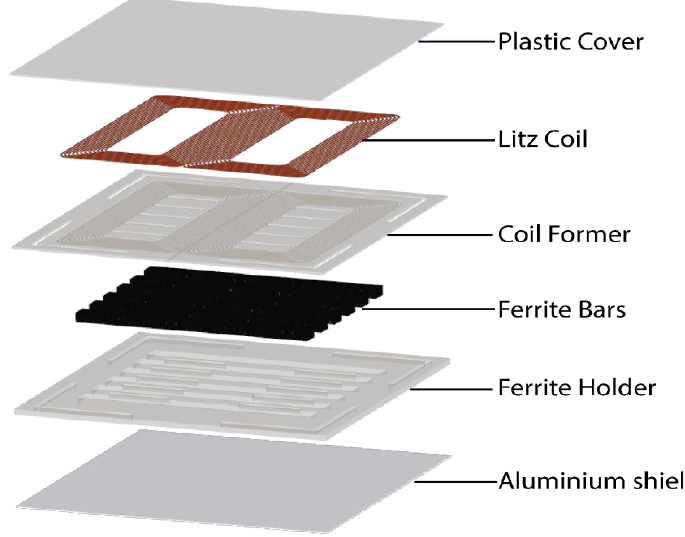
Figure 4. Exploded view of DD coil pad with accessories.